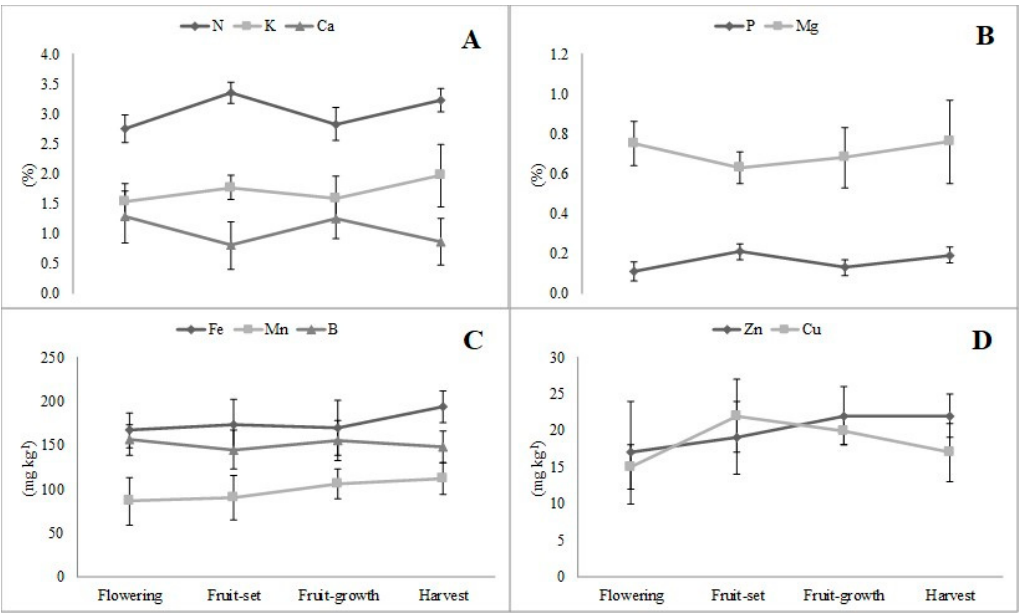
Figure 3. Pooled ( A , B ) macro and ( C , D ) micro leaf nutrient content in phenological stages during two monitoring seasons of terraced cherimoya trees for both systems. Bars are standard deviation ( n = 8).